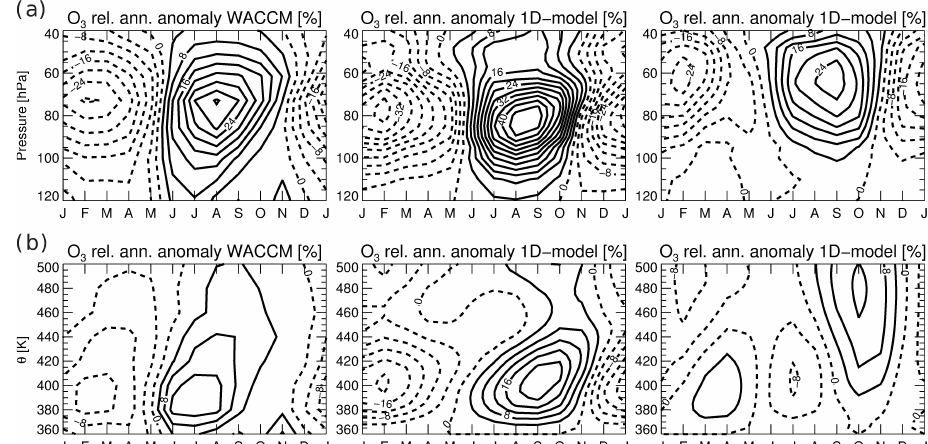
Fig. 1. Relative annual anomaly for tropical (20 ◦ S–20 ◦ N) ozone on pressure levels (a) and on isentropes (b) [%]. Percentages are relative to the annual mean concentrations. Results are shown from WACCM (left), from the 1-D model (middle) and from the 1-D model without including in-mixing (right). Solid (dashed) contours indicate positive (negative) values. Contour interval: